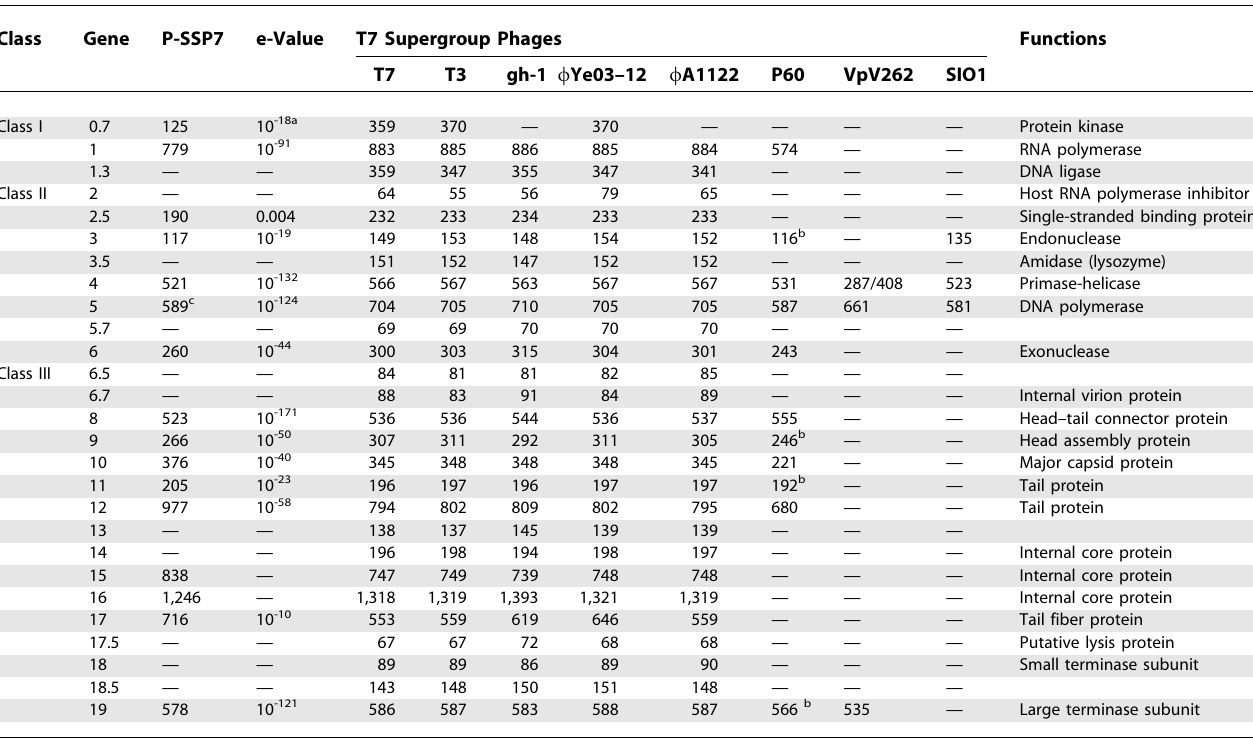
Table 2. Shared Genes in T7-Like Phages